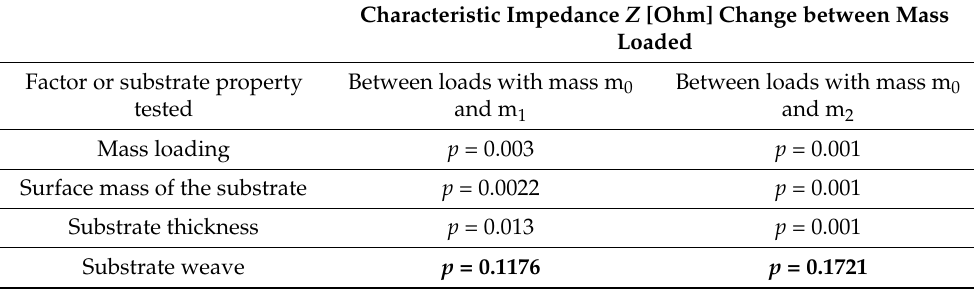
Table 6. Kruskal-Wallis non-parametrical test summary for curved